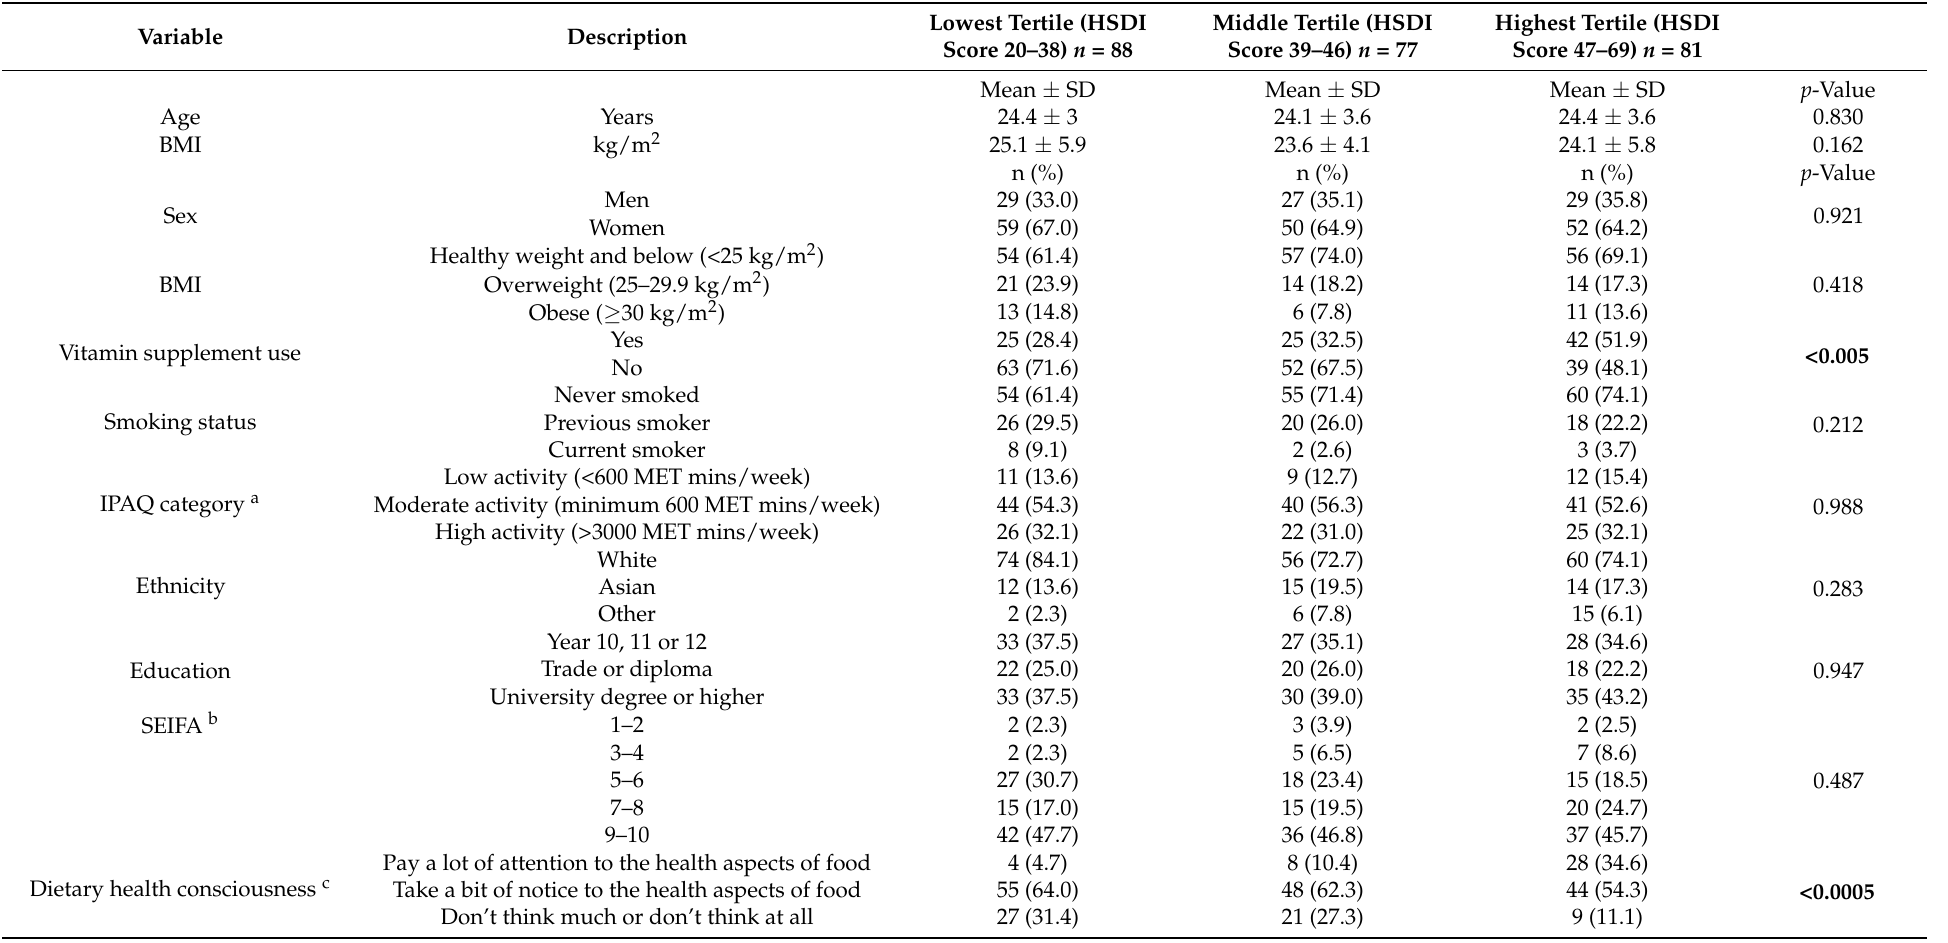
Table 3. Differences between total HSDI score * tertiles at baseline, using One-way ANOVA (continuous variables) and Chi-Squared test (categorical variables) ( n =